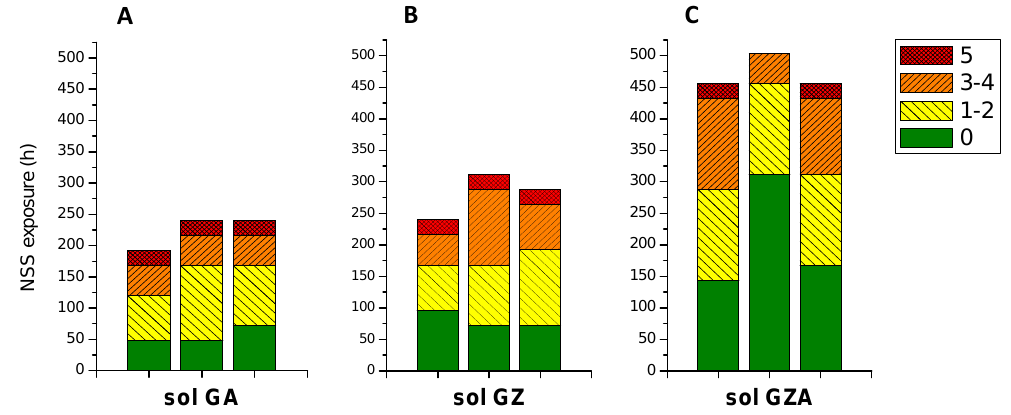
Figure 3. Corrosion resistance to NSS test for coatings obtained from GA ( A ), GZ ( B ) and GZA ( C ) sols.